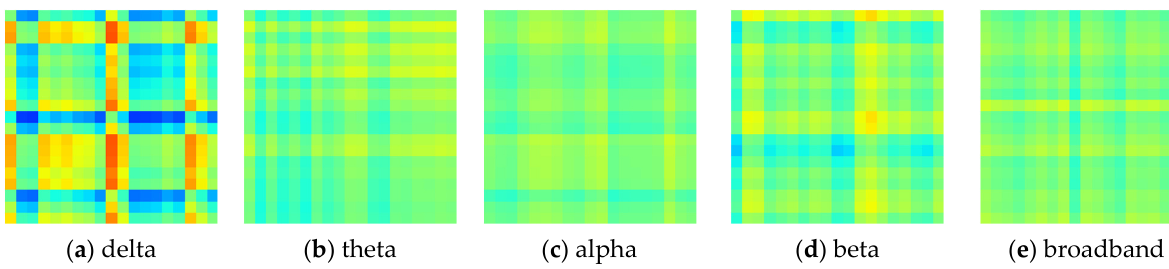
Figure 11. Example of severe sample (BDI score is 30)’s deep-asymmetry image by each band.